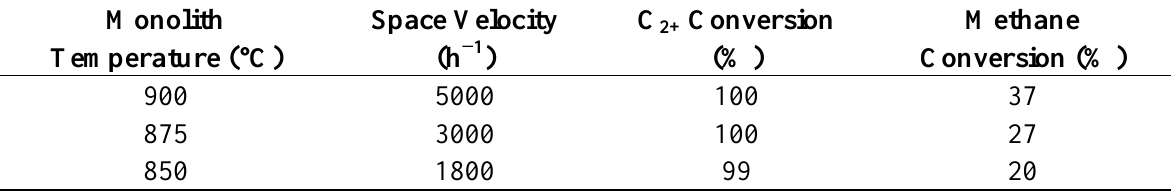
Table 1. Reforming of biomass gasification products on a MNS-washcoated cordierite monolith in the presence of H S. 2